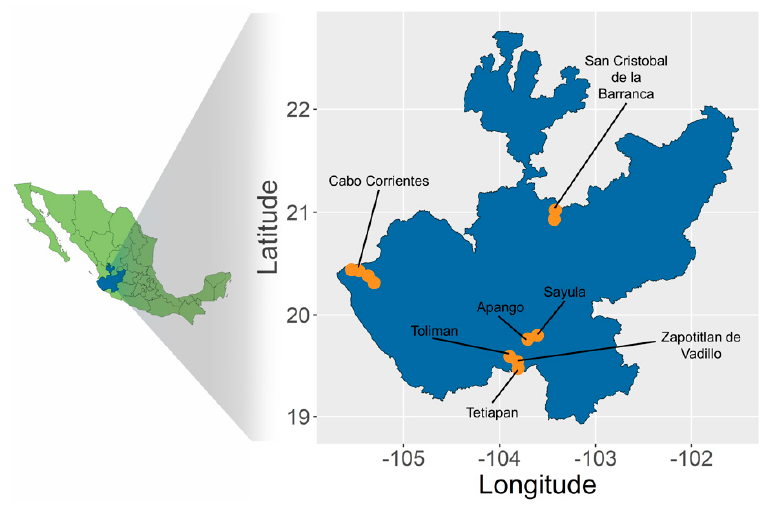
Figure 1. Area of study (Jalisco, Mexico) and localities where samples were